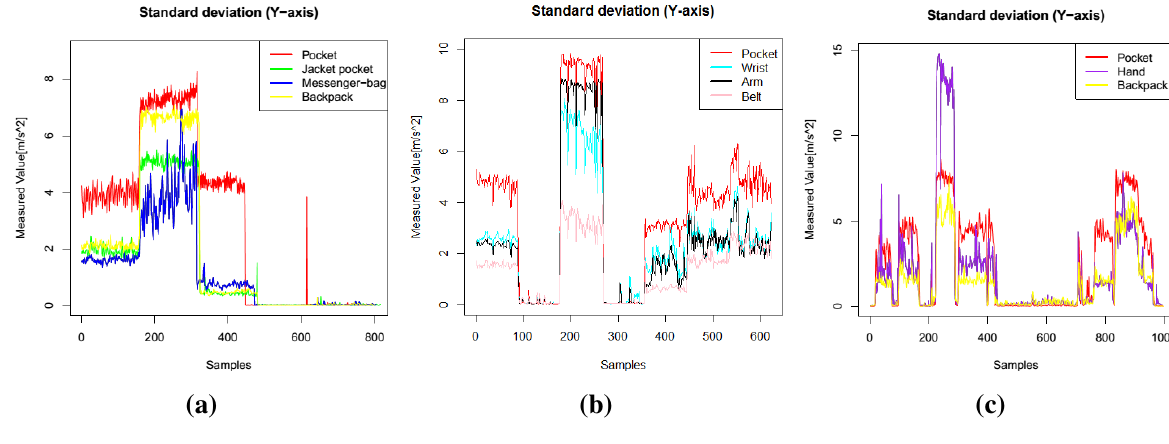
Figure 3. Standard deviation, y axis features. ( a ) Dataset 1; ( b ) Dataset 2; ( c ) Dataset